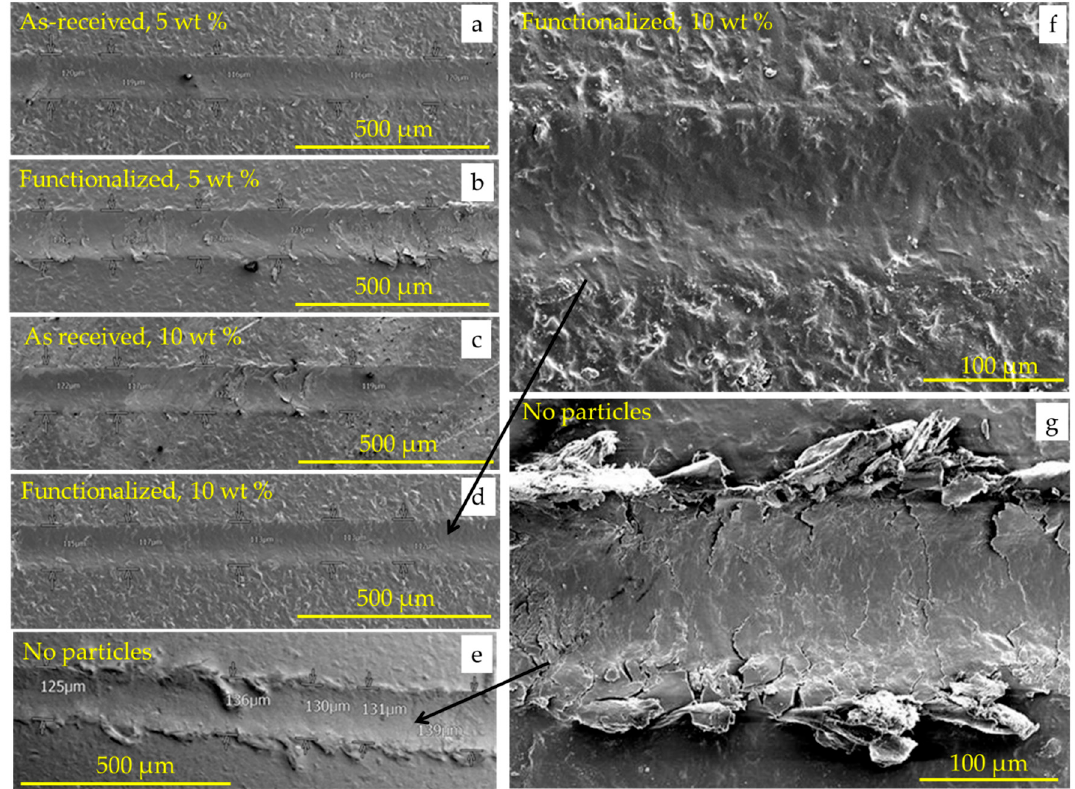
Figure 5. SEM images of laminate surfaces after the micro scratch test with a constant load of 6 N. Laminates containing ( a ) 5 wt % of as-received particles; ( b ) 5 wt % functionalized particles; ( c ) 10 wt % of as-received particles; ( d ) 10 wt % of functionalized particles, and ( e ) no particles; ( f , g ) 10 wt % of functionalized particles and no particles, respectively, with higher magnification.